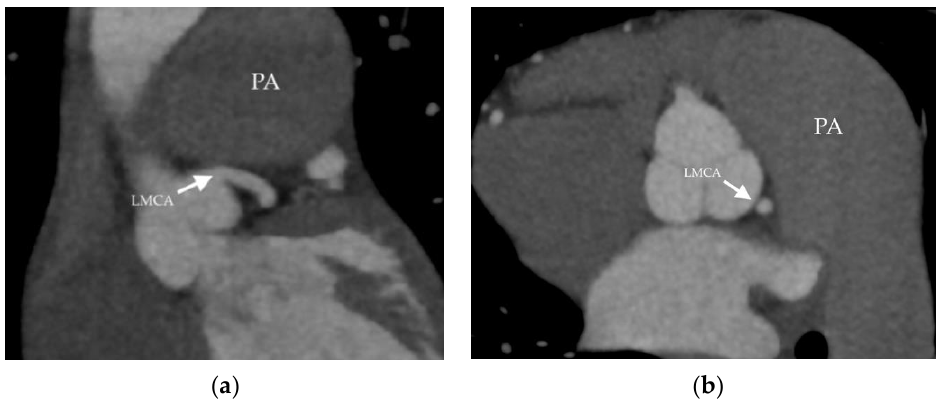
Figure 7. Coronary computed tomography angiography (Patient 2). The arrow points to the left main coronary artery (LMCA)- not compressed by the dilated pulmonary artery (PA): ( a ) sagittal view; ( b ) axial view .